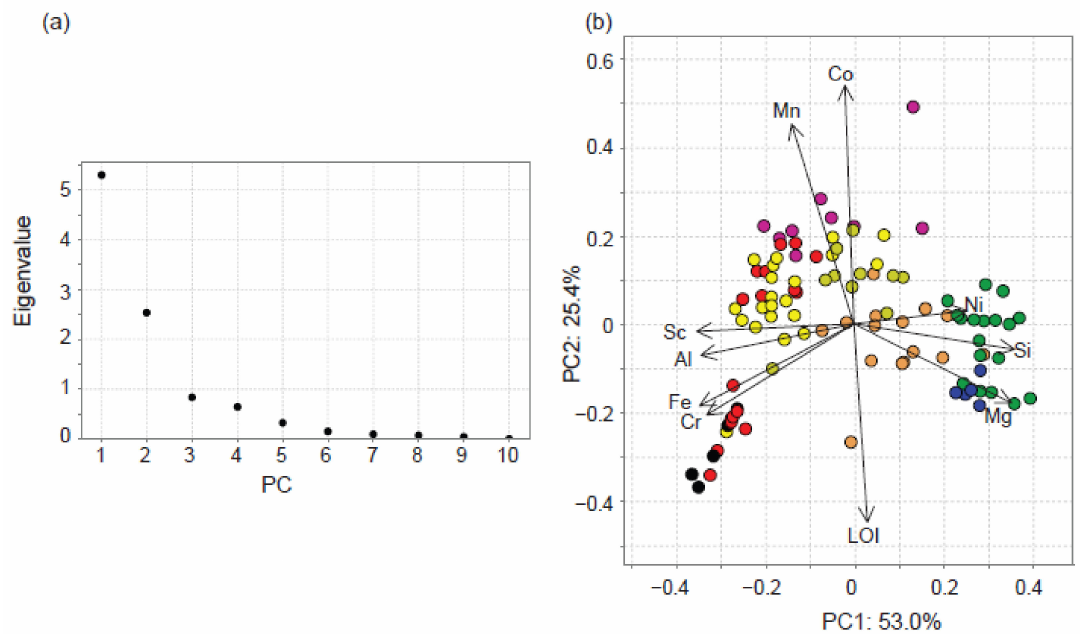
Figure 6. Results of PCA performed after centred log-ratio transformation of Mg, Al, Si, Sc, Cr, Mn, Fe, Co, and Ni concentrations and LOI from the global whole-rock geochemical dataset of peridotite-derived laterites (Ma-Oui, Coquette Red and East Alpha). Saprolitised gabbro samples from East Alpha were excluded from PCA calculations. ( a ) Scree plot. ( b ) PC1-PC2 biplot showing variable loadings (arrays) and sample scores (circles). See Figure 5 for lithology colour